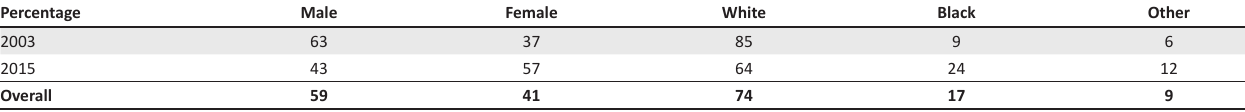
TABLE 1: Author demographics (gender and race) for the South African Journal of Human Resource Management: 2003–2015.